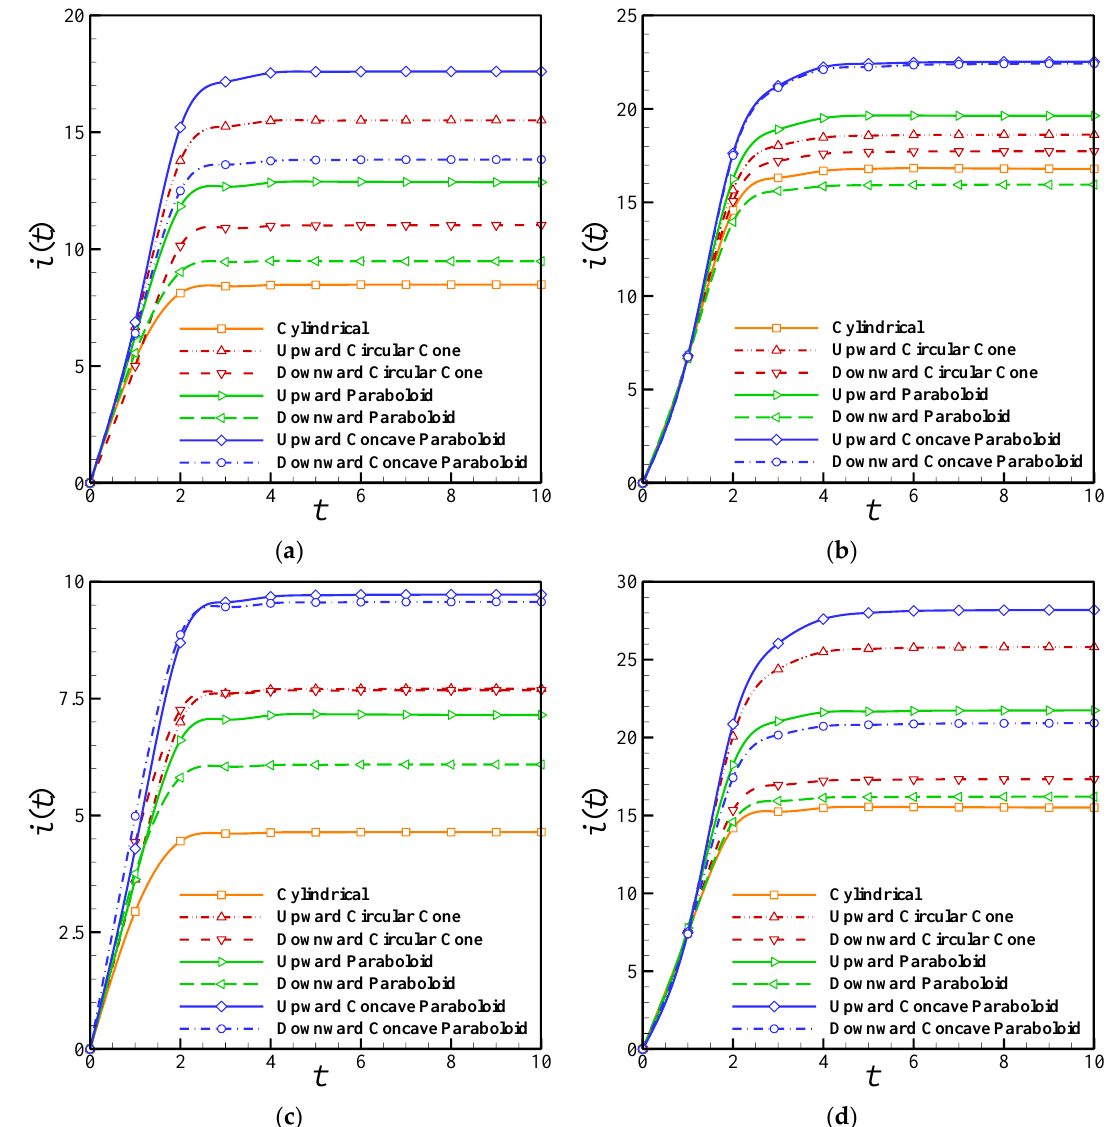
Figure 7. Dependency of the output current on the perforation level ( γ = 0.5): ( a ) α = 0.2, ( b ) α = 0.8. The enzyme filling level ( α = 0.5); ( c ) γ = 0.05; ( d ) γ =